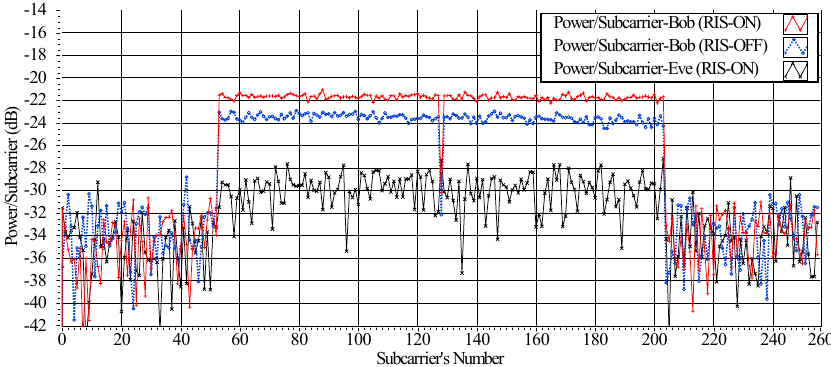
Figure 6. The power/subcarrier for N = 256 at the side of Bob and Eve, with/without the RIS.